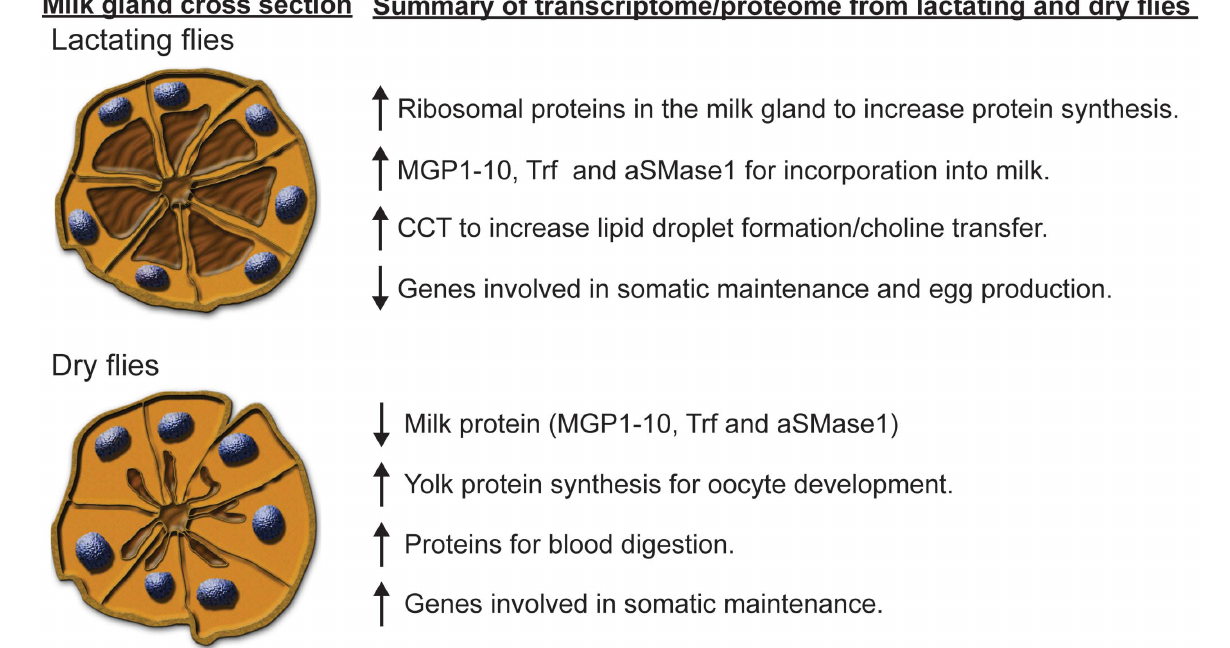
Figure 11. Summary of the results from our tsetse fly lactation study. The cross section of the milk gland tubules was adapted from Yang et al. [12] and modified according to Ma et al. [33] to represent tubules in a lactating fly, characterized by secretory vacuoles full of milk and condensed nuclei, and in the milk gland of a dry fly, characterized by exhausted secretory vacuoles and expanded nuclei.